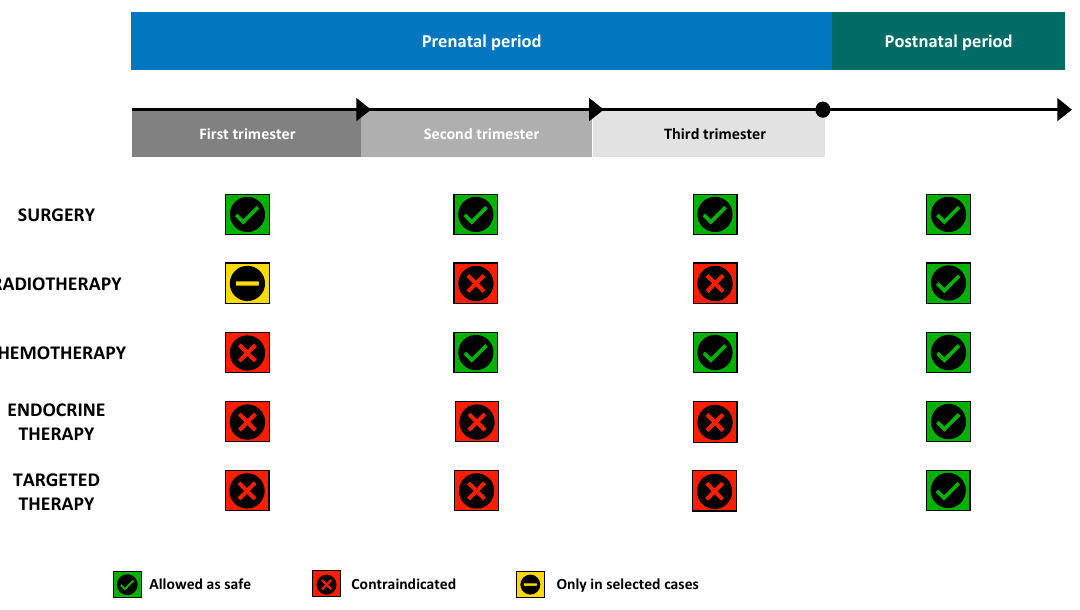
Figure 2. Overview of the use of anticancer treatments for breast cancer diagnosed during pregnancy.